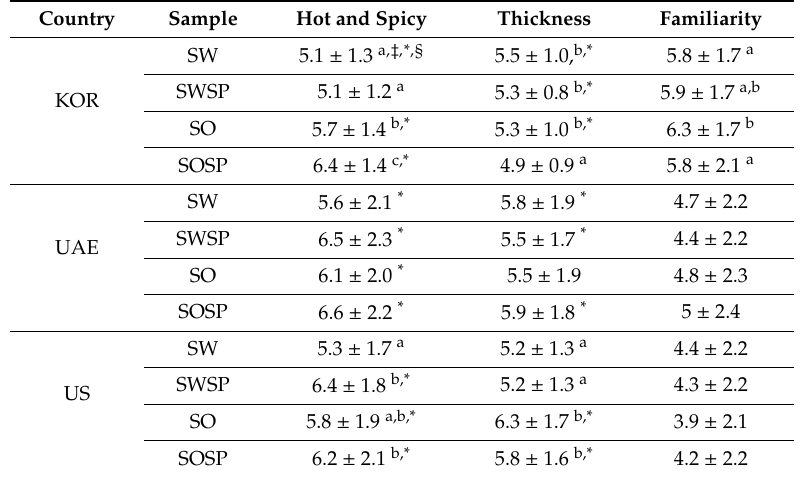
Table 6. Ratings (mean ± SD) of intensities and familiarity of spicy dipping sauce samples evaluated by the KOR, UAE, and US †